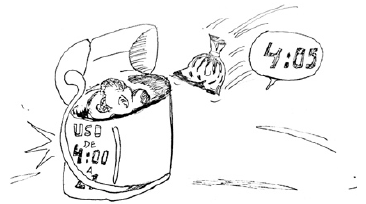
Figure A5. Civic pictures.